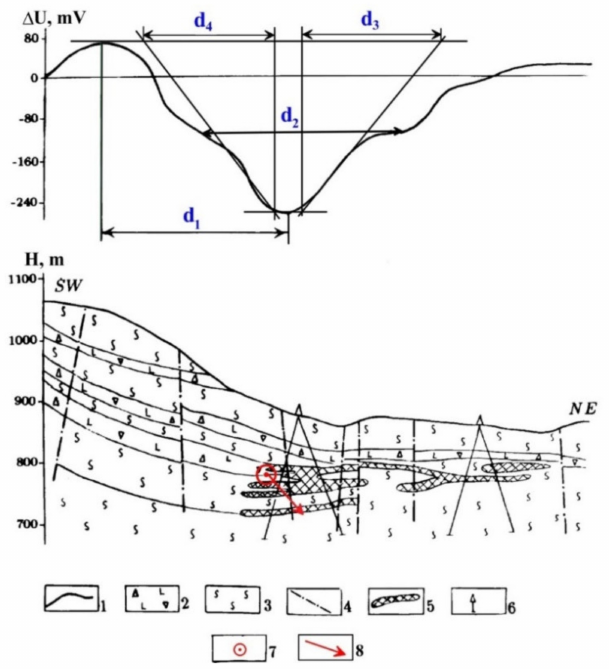
Figure 9. Interpretation of SP anomaly in the area of the Uchambo ore field of the Adjar group of copper-polymetallic deposits (Georgia, Lesser Caucasus). (1) SP observed values; (2) heteroclastic tuff breccia and their tuffs; (3) cover trachyandesite-basalts with pyroclastic interbeds; (4) disjunctive dislocations; (5) zones of increased mineralization; (6) drilled wells; (7) location of HCC center according to the interpretation results, (8) orientation of self-potential vector (1–6) from